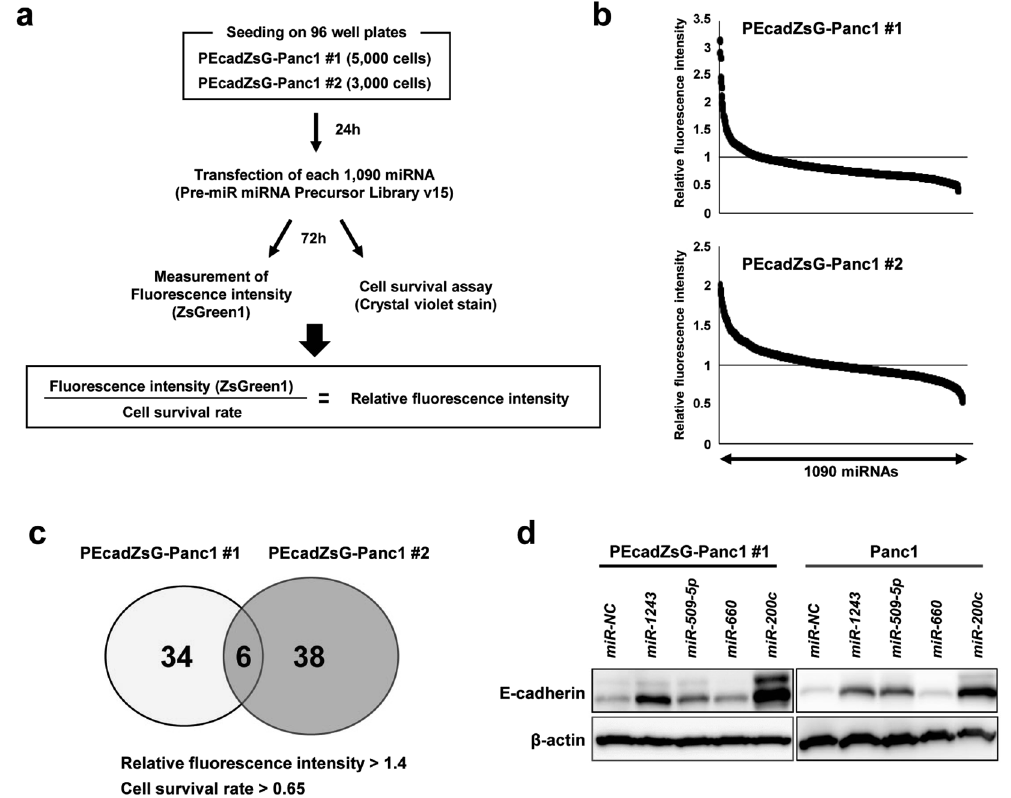
Figure 1. EMT-suppressive miRNAs are extracted using the function-based screening by combining the cell- based reporter system and an miRNA library in Panc1 clones. ( a ) Flow chart of the study. ( b ) Result of the function-based screening using Pre-miRTM miRNA Precursor Library-Human V15, which contains 1,090 miRNAs mimicking human mature miRNAs. The fluorescence intensity of ZsGreen1 was measured in duplicate with a fluorescence microplate reader. The relative fluorescence intensity in each transfectant was calculated using the fluorescence intensity in negative control cells and was normalized based on the cell survival rate, as measured by the crystal violet stain (Supplementary Table S1). The lower closed arrow indicates the 1090 miRNAs examined. ( c ) Venn diagram showing the overlap of six miRNAs between PEcadZsG-Panc1 #1 and #2. ( d ) The expression of E-cadherin in PEcadZsG-Panc1 #1 and parental Panc1 cells transfected with each candidate miRNA that was selected in the screening.